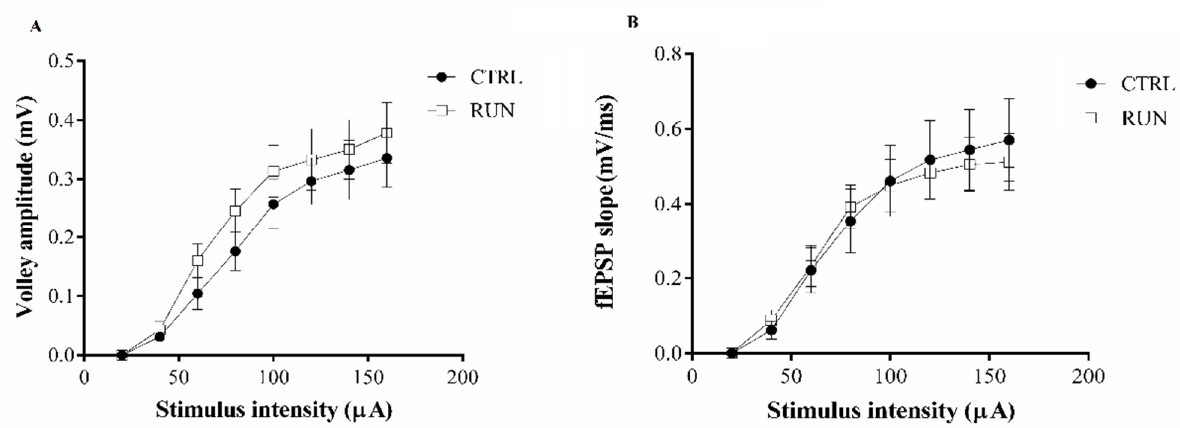
Figure 1. Basal synaptic transmission evaluation. Input-output of stimulus plots versus fiber volley amplitude ( A ) and stimulus versus fEPSP slope ( B ) in CTRL and RUN group. Field potential and fiber volley amplitude responses to increasing intensity stimuli of the perforant pathway were not significantly different in the two groups.